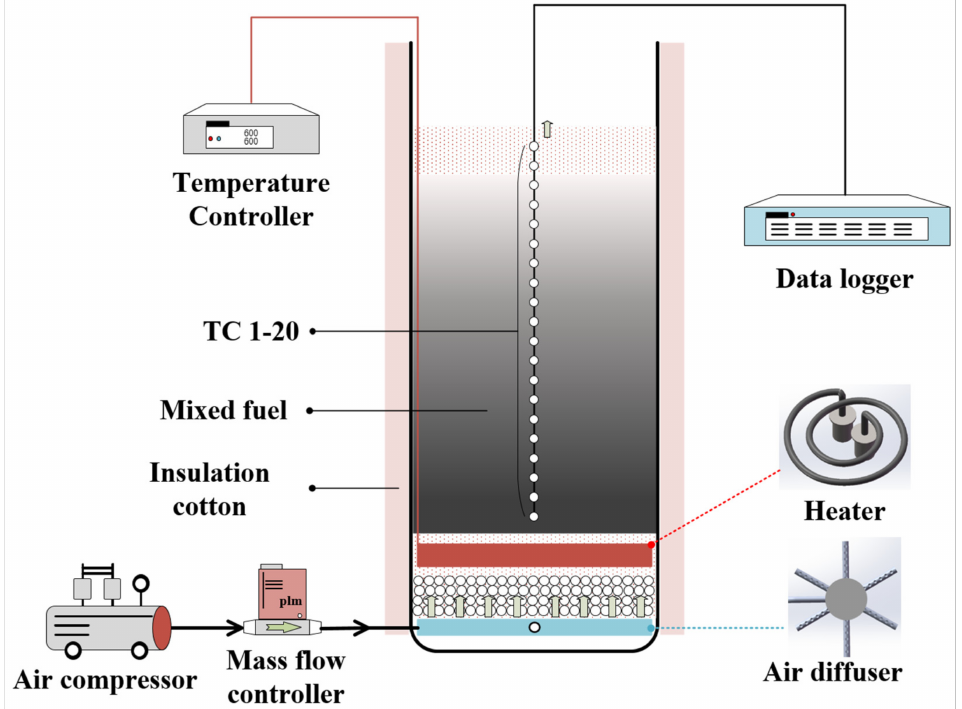
Figure 11. Schematic of smoldering experimental